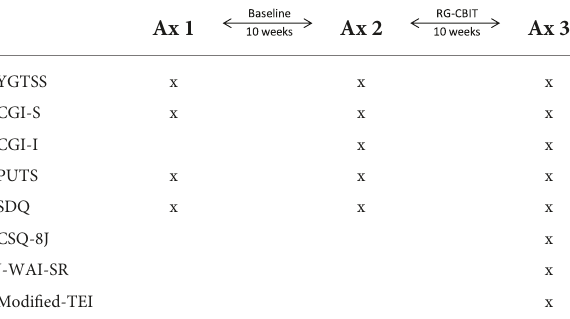
TABLE 2 Schedule of